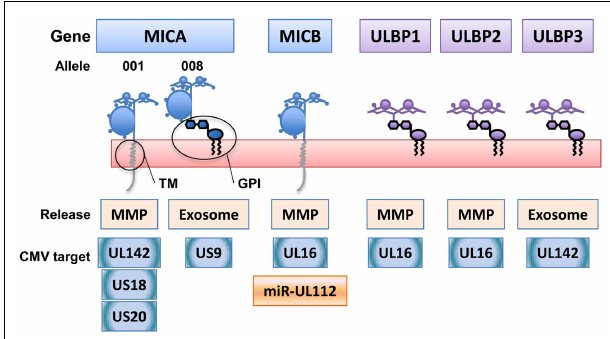
FIGURE 1 | NKG2D-ligands belong to two genetic families with multiple biochemical and cell biology features . The two genetic families of NKG2D-ligands, MICA/B (major histocompatibility complex class I-related chain) and ULBPs (UL16-binding proteins), encode proteins with different membrane attachments [transmembrane (TM) and glycosyl-phosphatidyl- inositol (GPI)] and different mechanisms for release to the extracellular milieu [exosomes versus metalloprotease (MMP) cleavage]. However, not all the members of one of these genetic families of NKG2D-ligands share the same biochemical characteristics. NKG2D-ligands are also differentially recognized by viral proteins and miRNAs that interfere with the immune response. As an example, the human cytomegalovirus evasion molecules targeting NKG2D-ligands (proteins in blue, miRNA in orange) are